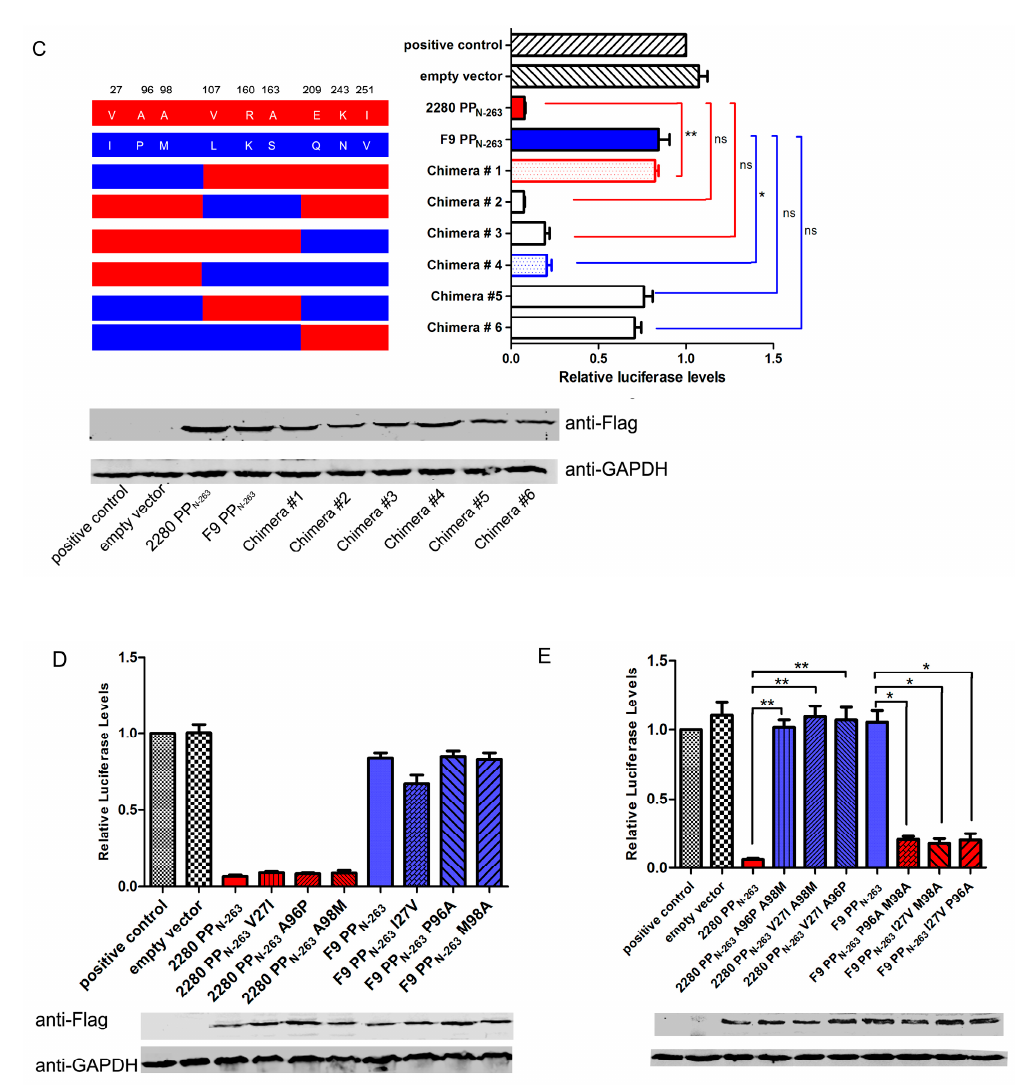
Figure 4. Identification of the key sites of PP for inhibiting host gene expression. ( A , B ) CRFK cells were transfected with 0.25 µ g of pIFN+33-Luc together with 0.25 µ g of pFlag-3CLP-87 and pFlag-3CLP-12 ( A ); 2280 PP N-263 and F9 PP N-263 ( B ) or empty vector. At 24 h post-transfection, SeV was inoculated into the cells for 10 h, and then cell lysates were subjected to luciferase assay and Western blot analysis using anti-Flag antibody; ( C–E ) Luciferase expression from pIFN+33-Luc in cells cotransfected with the indicated chimeric PP genes ( C ) or single ( D ) or double mutants ( E ) of PP in the p3 ˆ Flag-CMV vector. The expression of each construct was determined by Western blotting using an anti-Flag antibody. Anti-GAPDH was used as a loading control. Three independent experiments were performed and produced consistent results. The data represented the result of one experiment and were presented as means ˘ SD. *, p < 0.05; **, p < 0.01; ns,